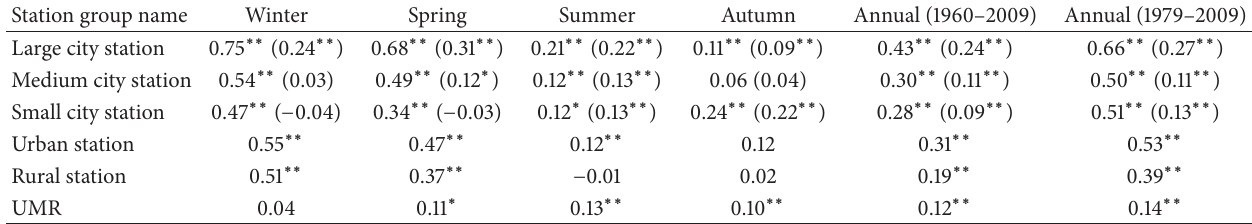
Table 3: Observed trends of the annual and seasonal mean surface air temperature for different station groups in the JJJ area. The values in parentheses are the results of different urban station groups minus the rural station. Statistical significance is 0.05 (single asterisk) and 0.01 (double asterisk). The units for the values are ∘ Cdecade − 1 .